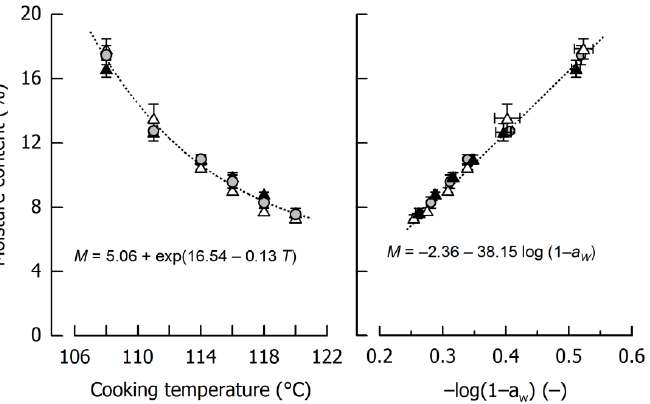
Figure 1. Dependency of caramel moisture content M on cooking temperature T ( left ) and relation between moisture content and water activity a W ( right ). Data are arithmetic mean ± standard deviation from 2 independent preparations per formulation and duplicate measurements ( n = 4). Symbols: Formulations Ref (grey circles), SFC1 (black triangles), SFC2 (open triangles). Equations refer to the fits indicated by dotted lines.